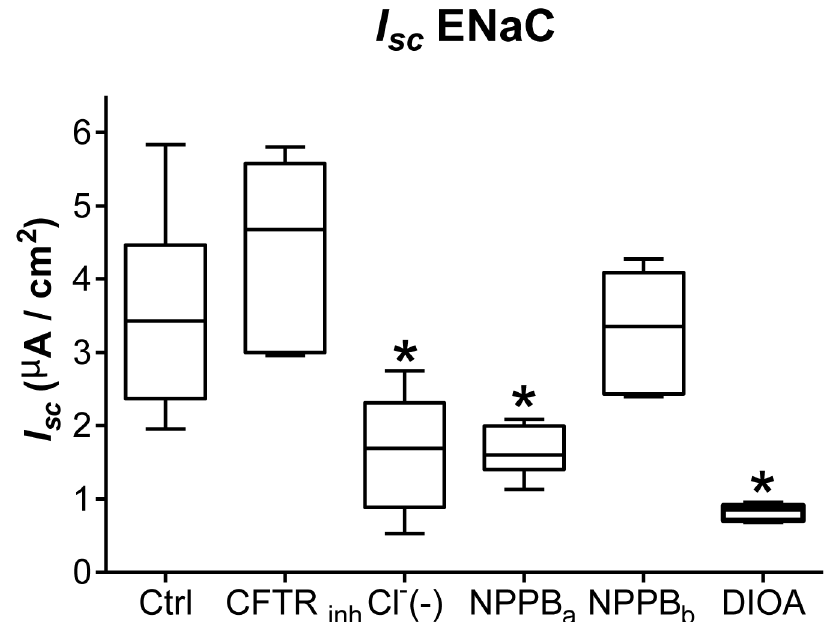
Figure 5. Role of apical Cl - channels and KCC co-transport in ENaC current magnitude. ENaC current values were determined after pretreatments with 20 µM CFTR inh-172 (CFTR inh), reduced Cl - buffer (9mM NaCl; 150 mM Na gluconate) (Cl - (-)), 100 µM apical NPPB (NPPB ), 100 µM basolateral NPPB (NPPB ), or 100 µM basolateral DIOA. In experiments where the cells a b were pre-treated with an inhibitor that impacted on I , hypotonic shock was induced when the current was stabilized. For apical and sc basolateral NPPB, a 5 to 10 min incubation was needed while the current stabilized after ~ 30 min for DIOA. Pre-treatment with CFTR inh-172 and NPPB did not have an impact on I ENaC. N≥5, *p<0.05 by Mann-Whitney Test compared to untreated controls b sc